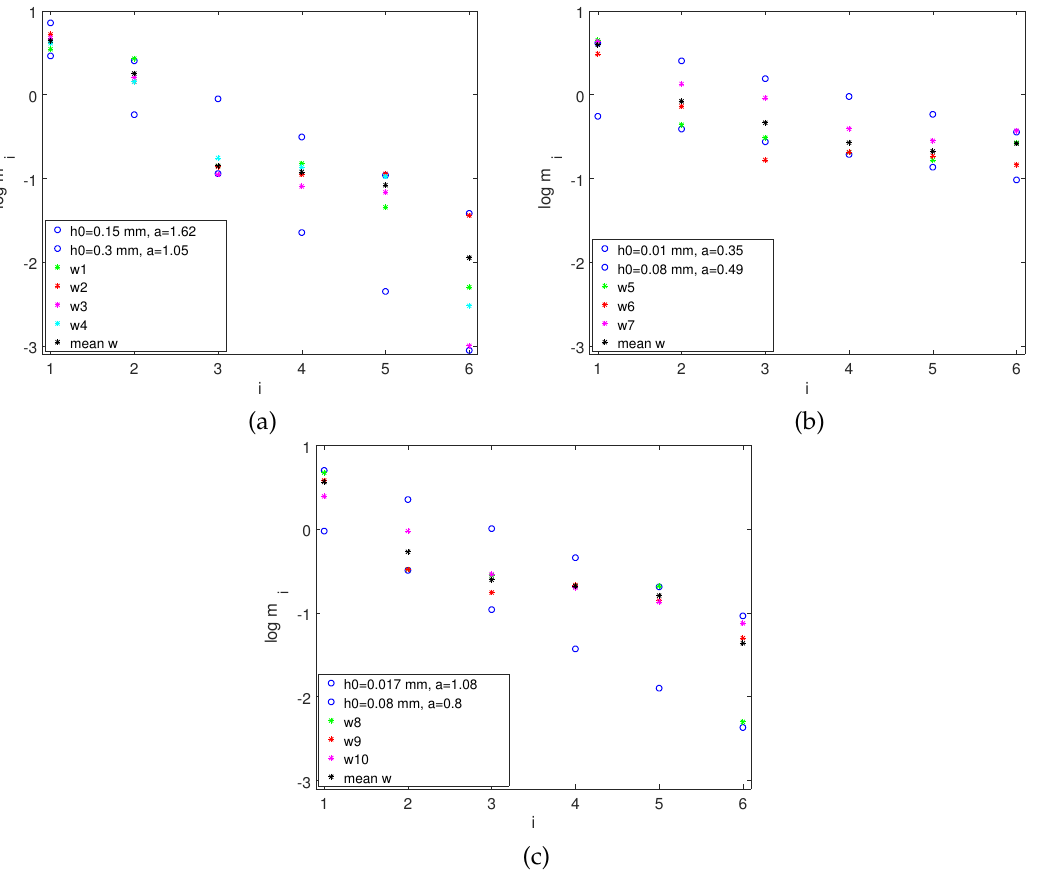
Figure 6. Lower and upper exponential bounds (marked by circles) in the logarithmic scale for ( a ) 15 mm, ( b ) 25 mm, and ( c ) 35 mm